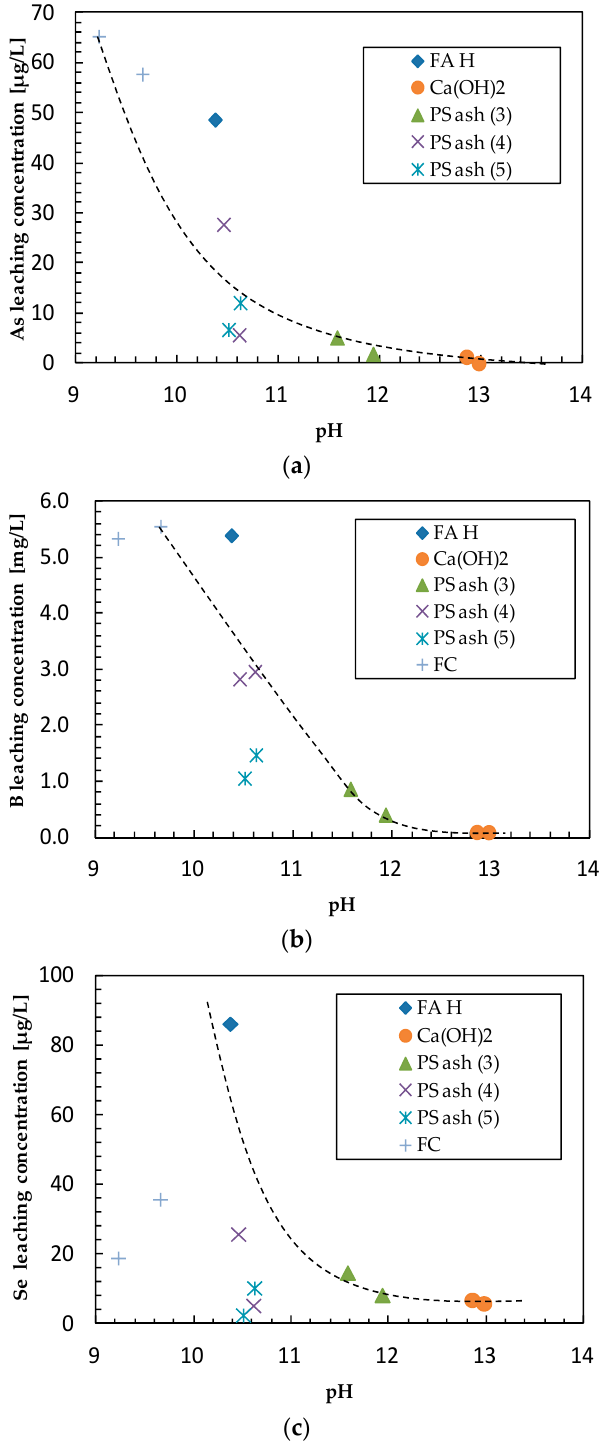
Figure 7. Relationship between the leachate pH and trace elements leaching concentration of five kinds of additives: ( a ) arsenic; ( b ) boron; and ( c ) selenium.